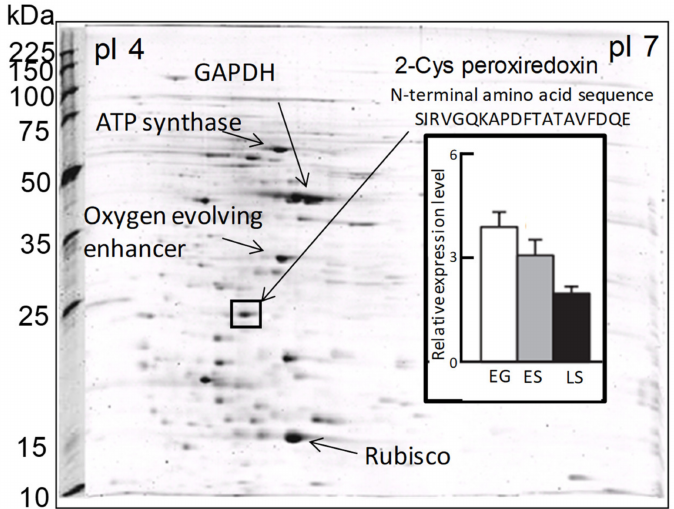
Figure 2. Two-dimensional gel electrophoresis profiles of Chattonella marina var. antiqua and some identified major protein spots, including 2-CysPrx. The bar graph shows the levels of 2-CysPrx protein expression in the exponential growth phase (EG), early stationary phase (ES), and late stationary phase (LS)